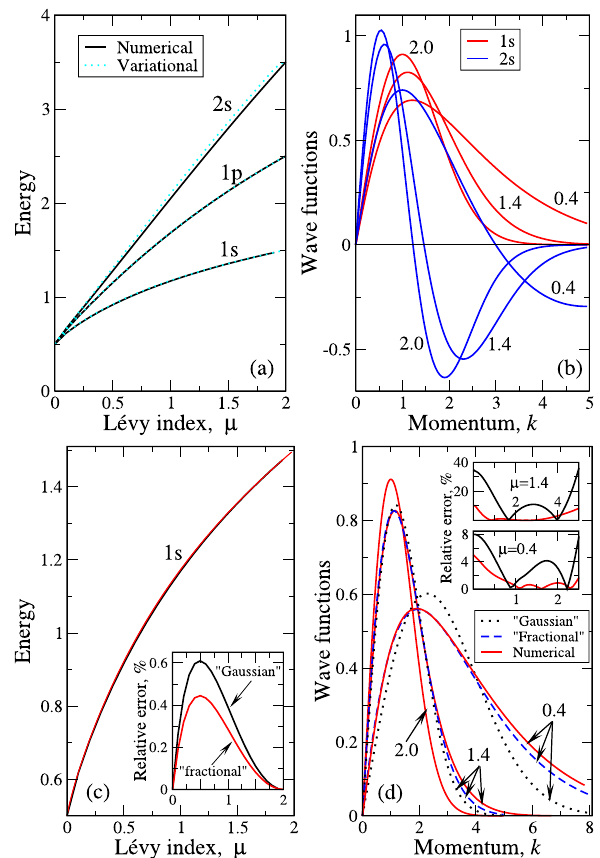
Figure 2. ( a ) Reports the lowest state eigenenergies (indicated near the curves) as functions of Lévy index µ , calculated numerically (solid lines) and variationally (dashed lines, “fractional” functions (13)–(15)). ( b ) Displays wave functions of the lowest states, shown in the legend. The numerical and variational plots in ( b ) are similar in the scale of the plot. ( c ) The 1s state energies, calculated variationally (expressions (26) and (31)) as well as numerically. The curves are indistinguishable in the scale of the plot. Inset in ( c ) reports the “Gaussian” - numerical (black curve) and “fractional”—numerical (red curve) relative errors in the entire µ domain. ( d ) Portrays the comparison between variational (both types of the functions, shown in the legend) 1.4 and numerical 1s wave functions for the same µ values, as in ( b ). Insets report the relative errors for µ = 2 is exact. Black curves correspond to “Gaussian”—numerical and red and 0.4 as the wave function for µ = ones to “fractional”—numerical relative errors as the functions of momentum k . Figures near curves in ( b,d ) correspond to Lévy indices µ